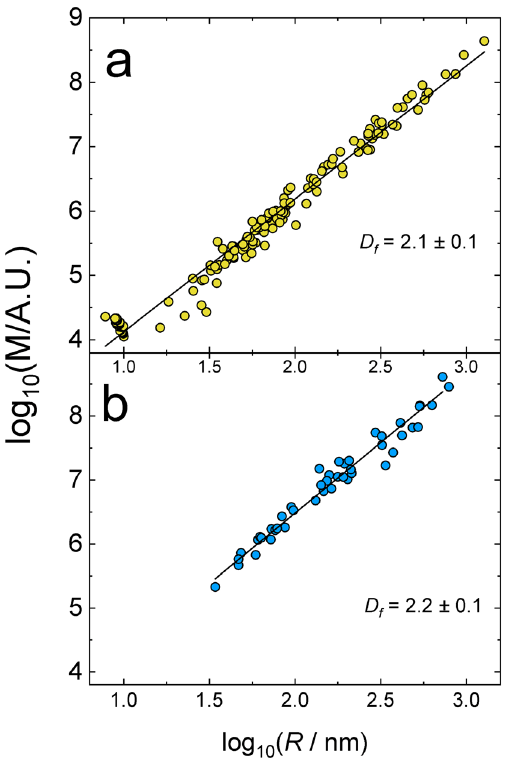
Fig. 5 Aggregate mass versus radius for aerosol particles sampled in the coal mine; a densitometric elaboration of TEM images, b aggre- gate approximation by spheres. Solid lines follow Eq.